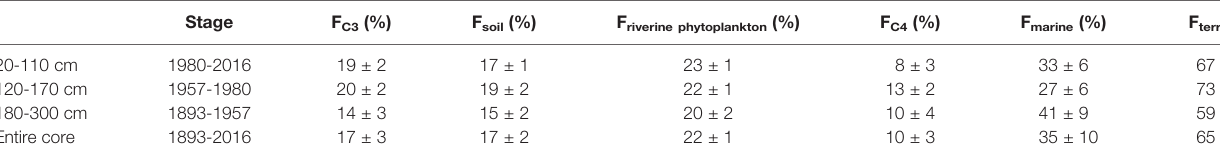
TABLE 2 | Fraction of C 3 plants, riverbank soil, riverine phytoplankton, C 4 plants, marine algae and total terrestrial OC in PRE sediments. Stage F C3 (%)